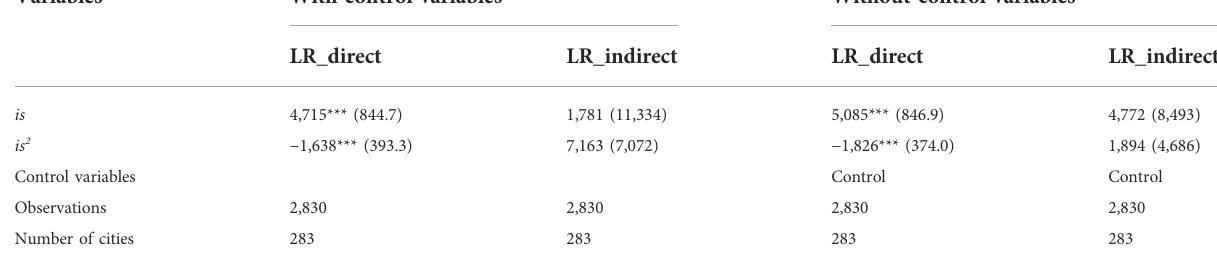
TABLE 4 Spatial spillover effect